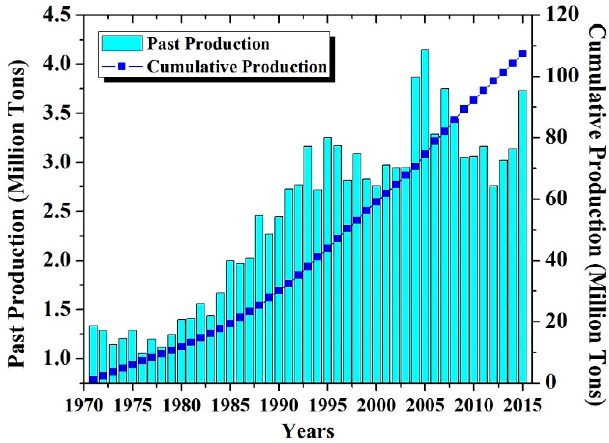
Figure 10. Coal past vs. cumulative production in million tons.